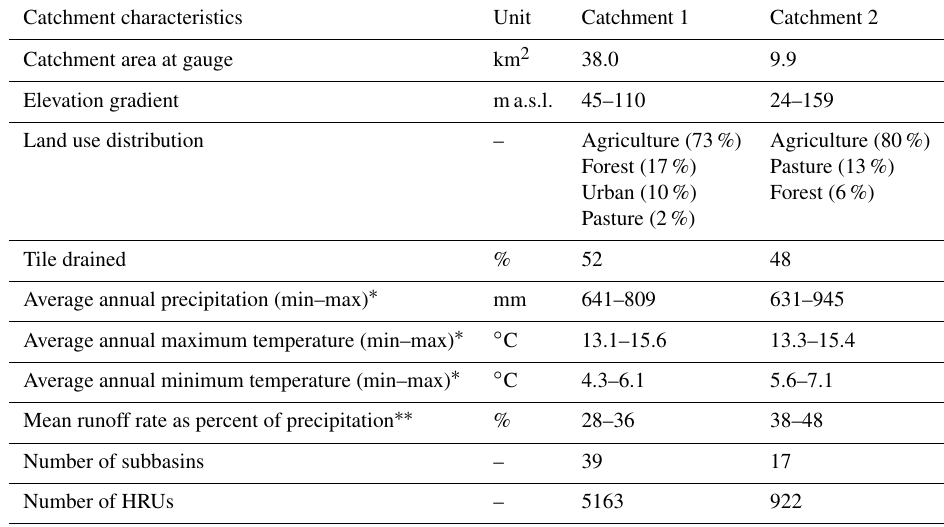
Table 1. Catchment characteristics of the two anonymized catchments in Western Europe.